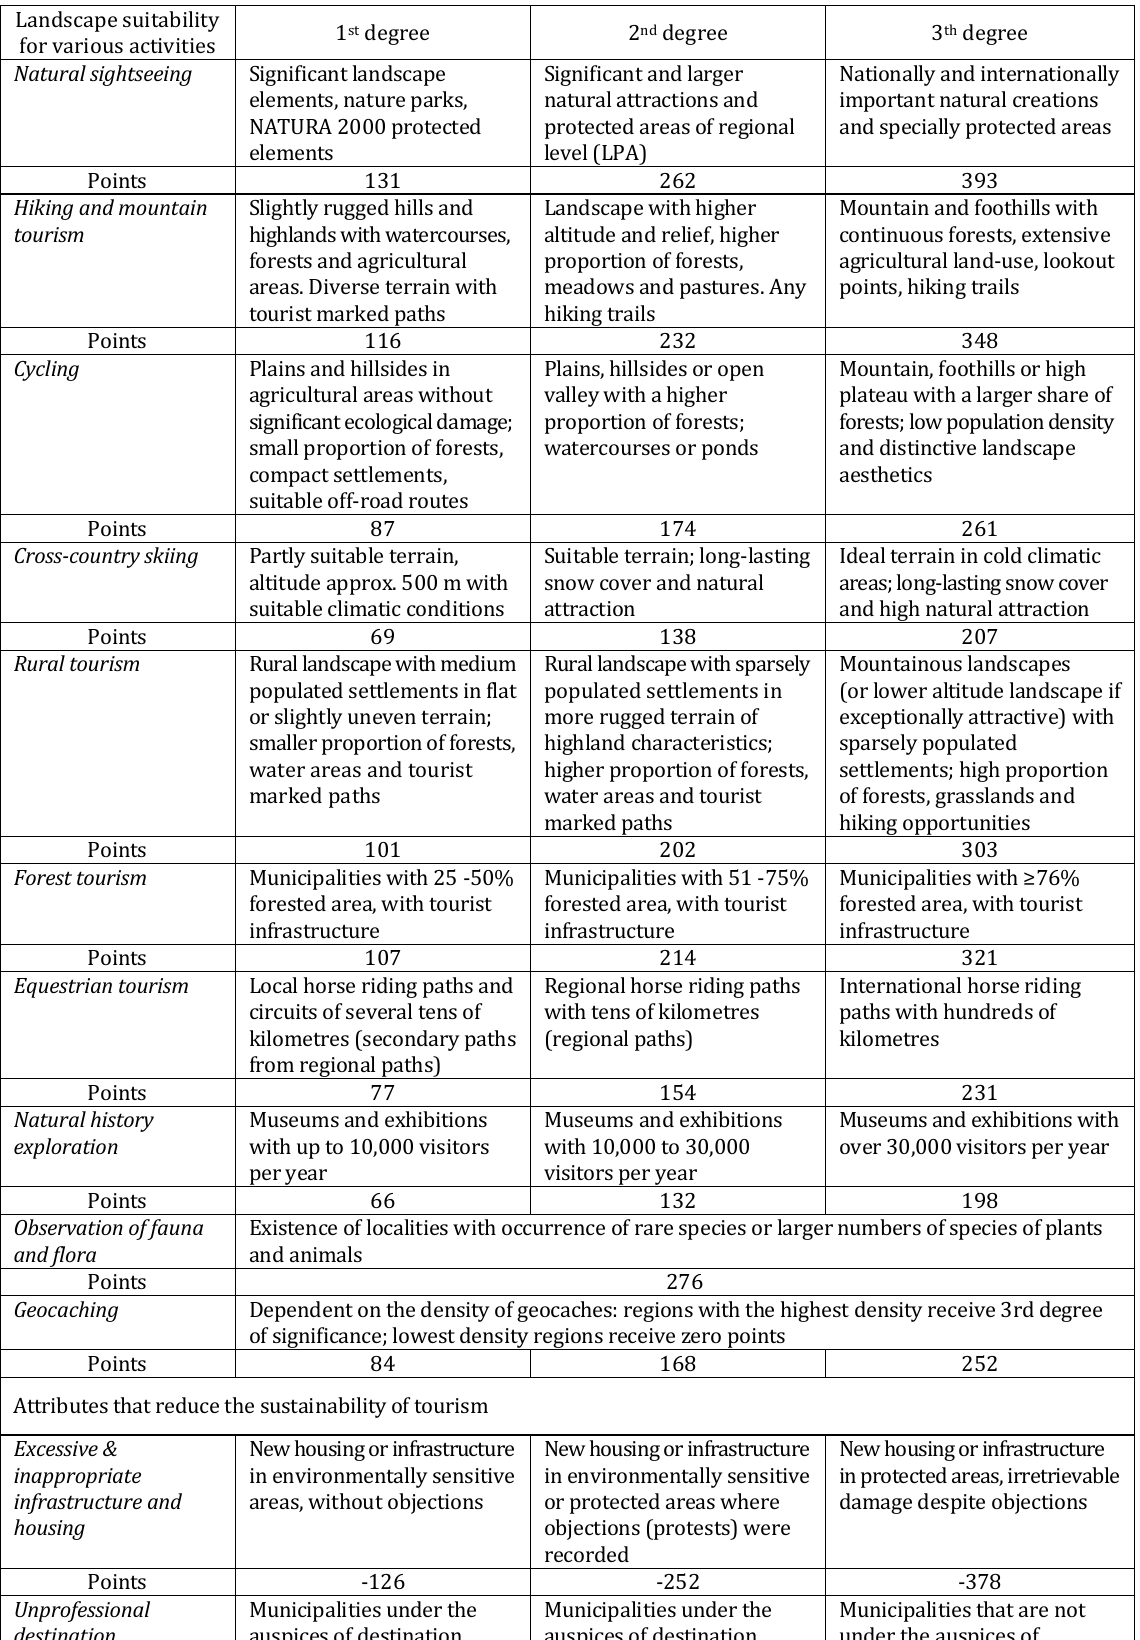
Table 1. Proposed methodology (Author’s own